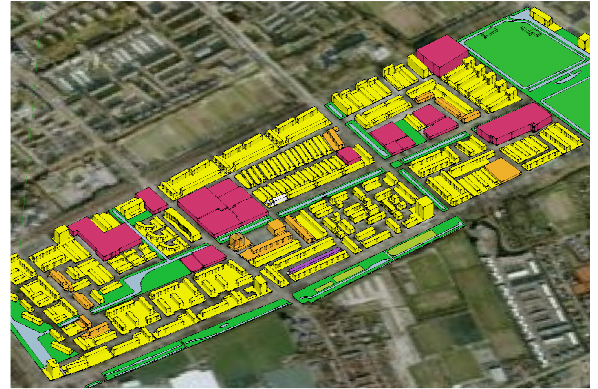
Figure 2. 3D representation of the spatial planning map in 3D IMRO GML, using attributes from the regulations such as colour and maximum allowed building height